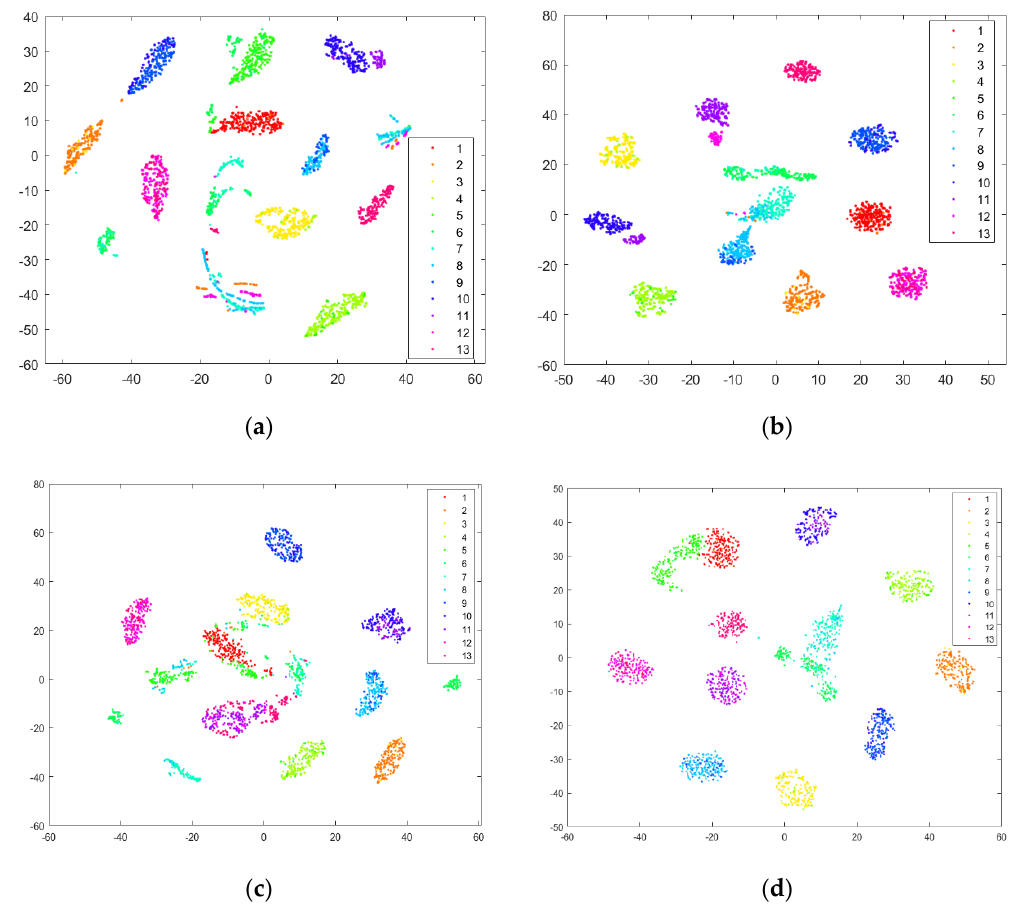
Figure 13. Feature visualization of ( a ) dataset1 using the standard CDBN, ( b ) dataset1 using the improved CDBN, ( c ) dataset2 using the standard CDBN, and ( d ) dataset2 using the improved CDBN.